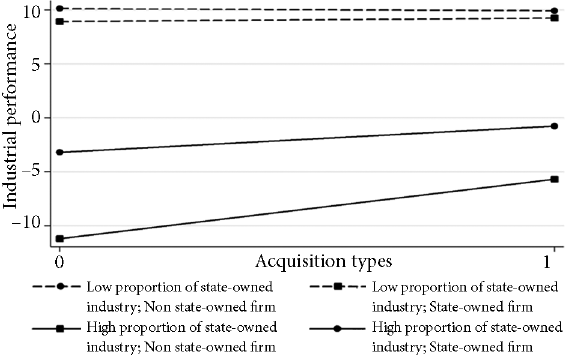
Figure 4. Joint moderation of industrial state-owned proportion and firm